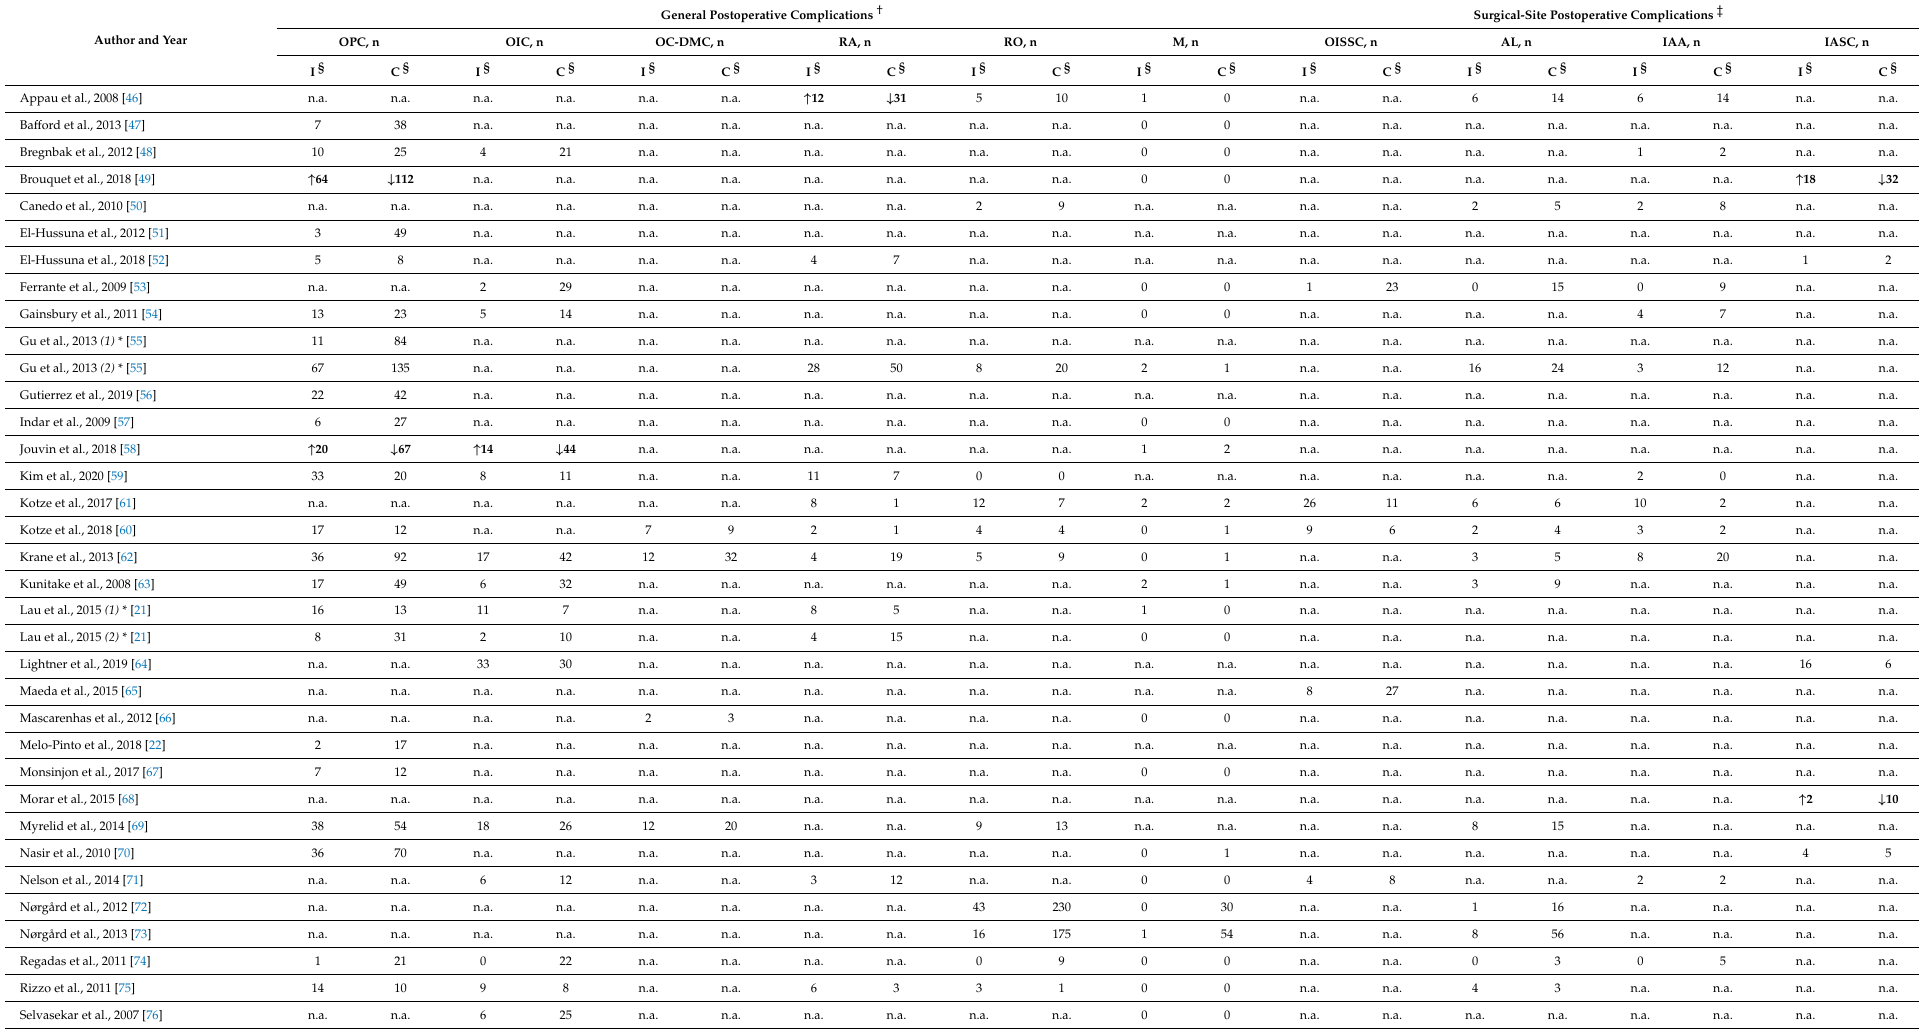
Table 2. 30-day general and surgical-site postoperative